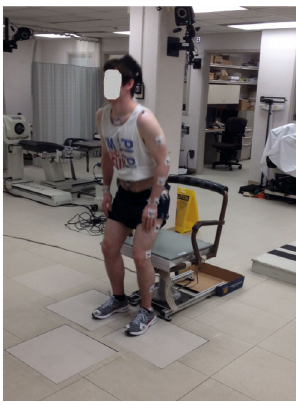
Figure 1: Marker placement locations on the human body. The 25 markers shown were needed for the hip, knee and ankle kinematic, and kinetic calculations, although some subjects in our study wore the full 47-marker set.